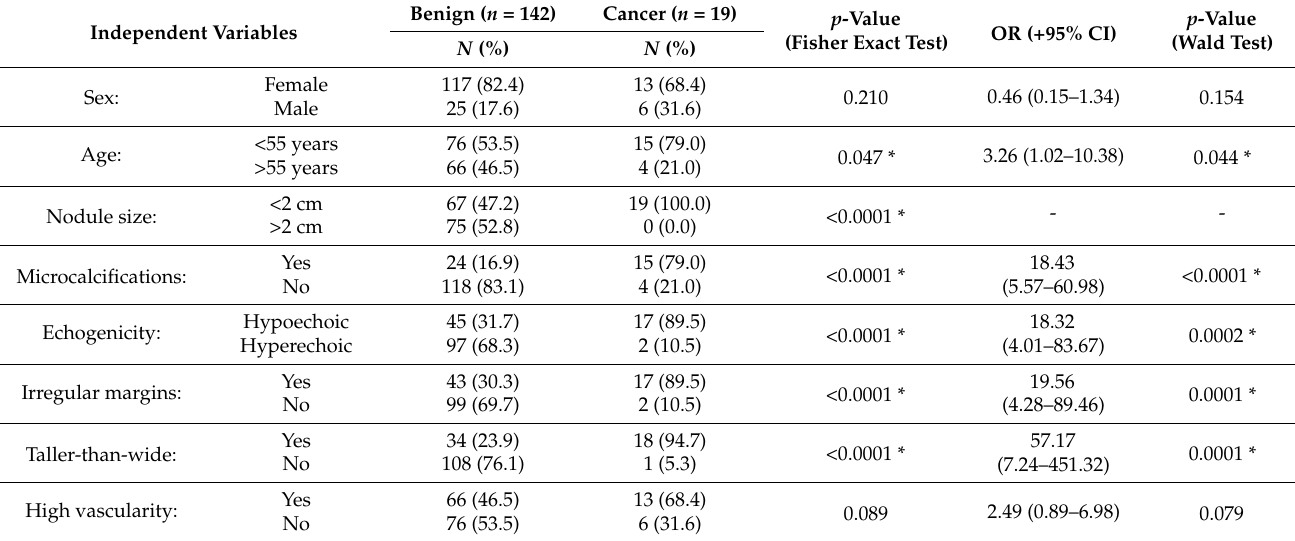
Table 2. Demographic parameters and ultrasound features as predictors for cancer presence in all patients with final diagnosis as AUS/FLUS ( n = 161). Analysis of contingency tables by Fisher’s exact test and multiple logistic regression analysis (0/1) was used to test the